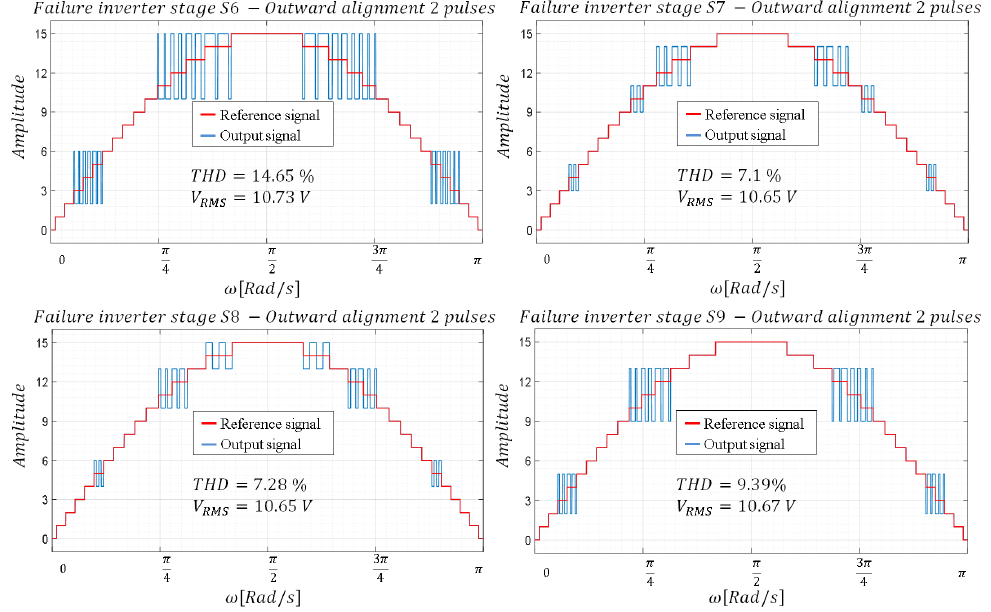
Figure 7. Waveforms—configuration with two pulses and outward alignment.